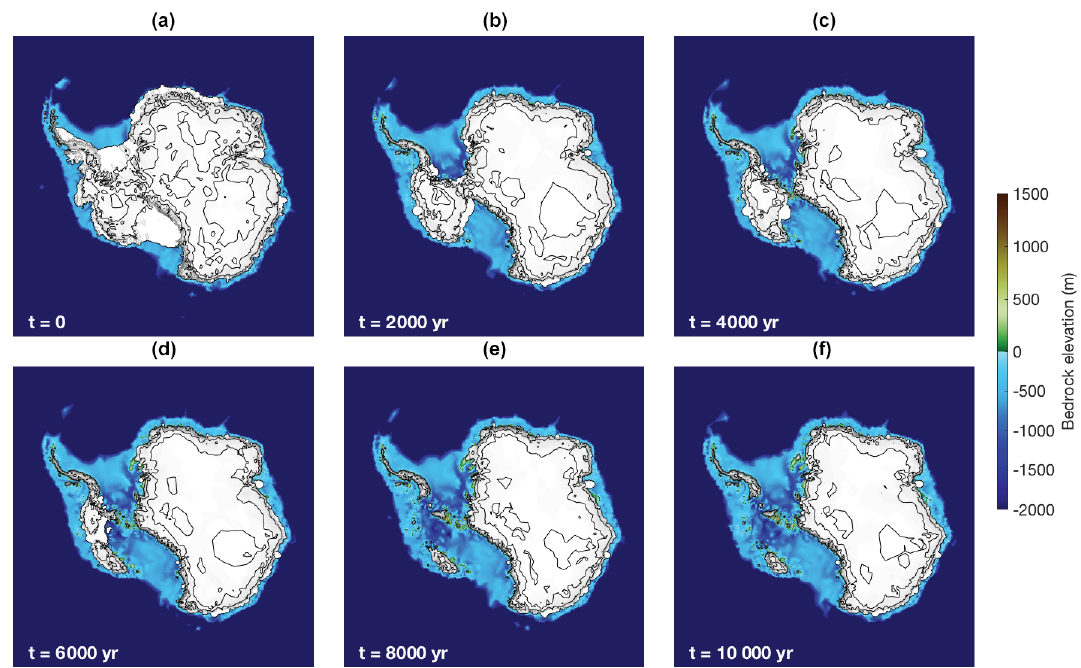
Figure 11. Results from the 10000-year Antarctic retreat simulation with a 4km grounding line resolution. Panels (a–f) show the modelled ice sheet at 2000-year intervals. Bedrock elevation is indicated by colours, surface elevation contours are shown at 1000m